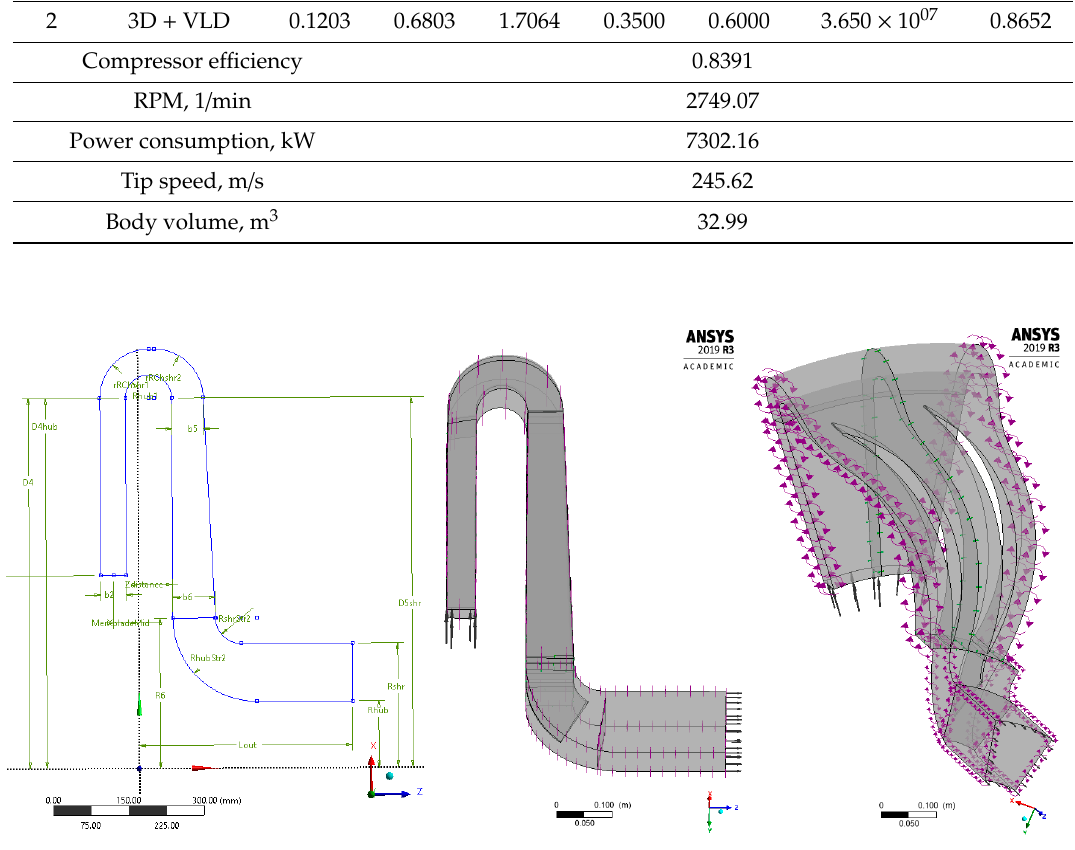
ψ = 0.45, 0.60 and Ф = 0.15 and des Т des